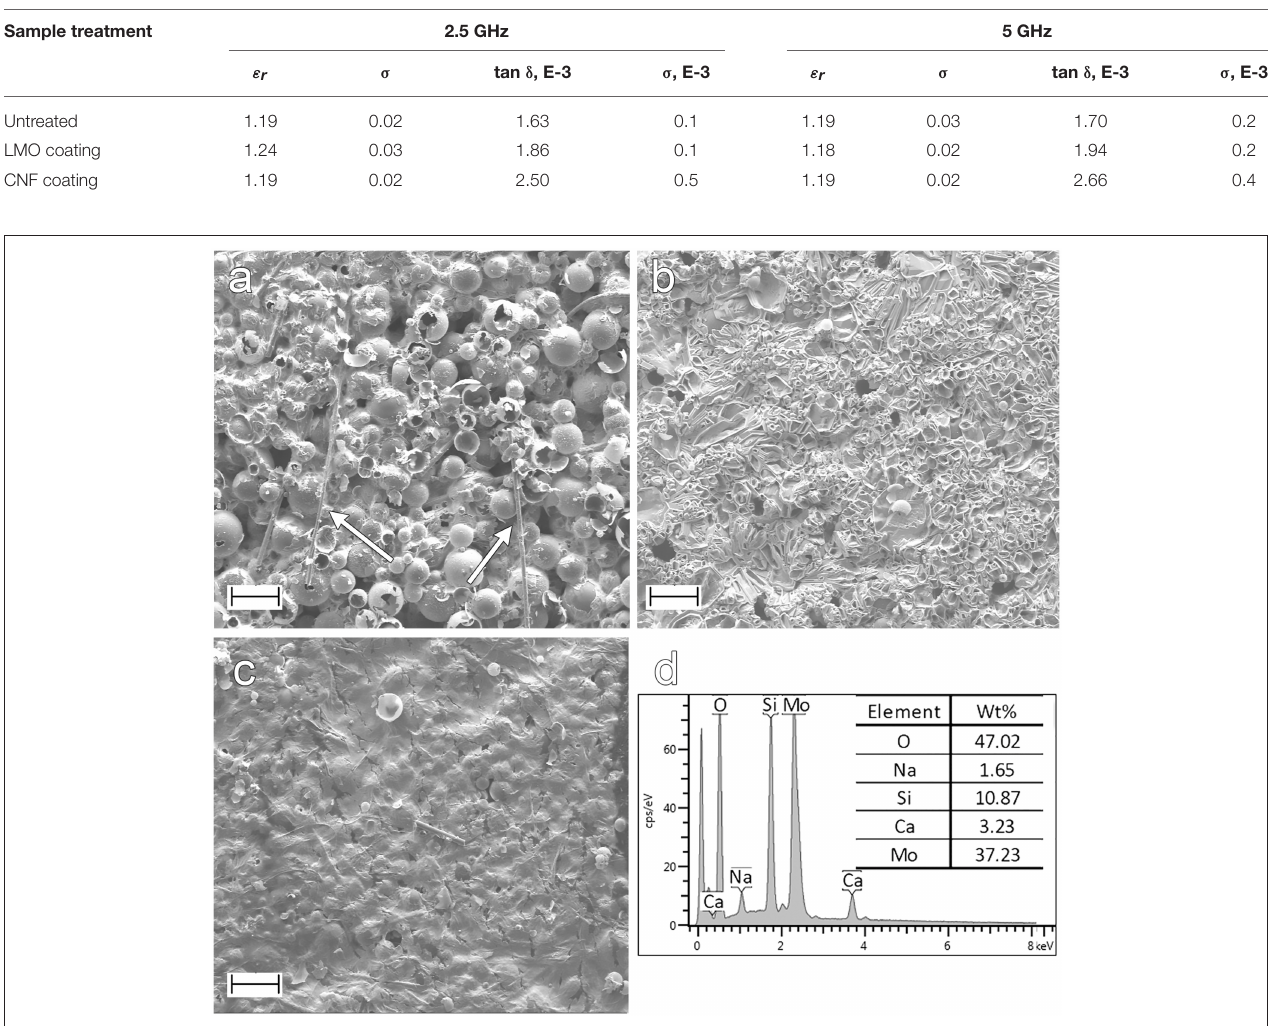
TABLE 1 | Dielectric properties with standard deviation of samples at 2.5 and 5 GHz. Sample treatment